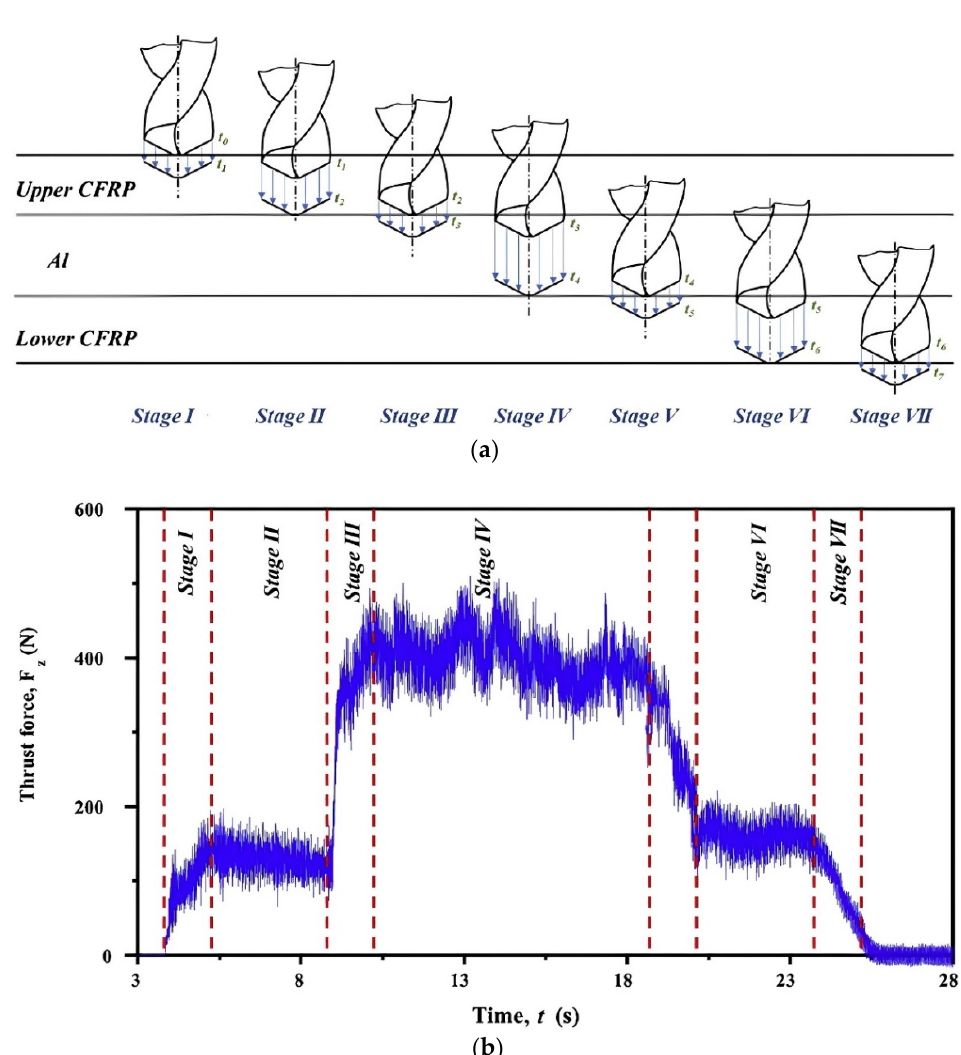
Figure 8. Drilling of CFRP/Al/CFRP co-cured materials: ( a ) stage division of the drilling process and ( b ) thrust force evolution as a function of cutting time [110].